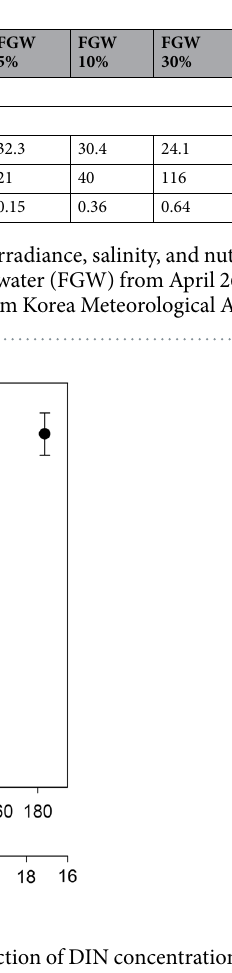
Figure 4. The growth rate of U. pertusa as a function of DIN concentrations and salinities by adding different amounts of fresh